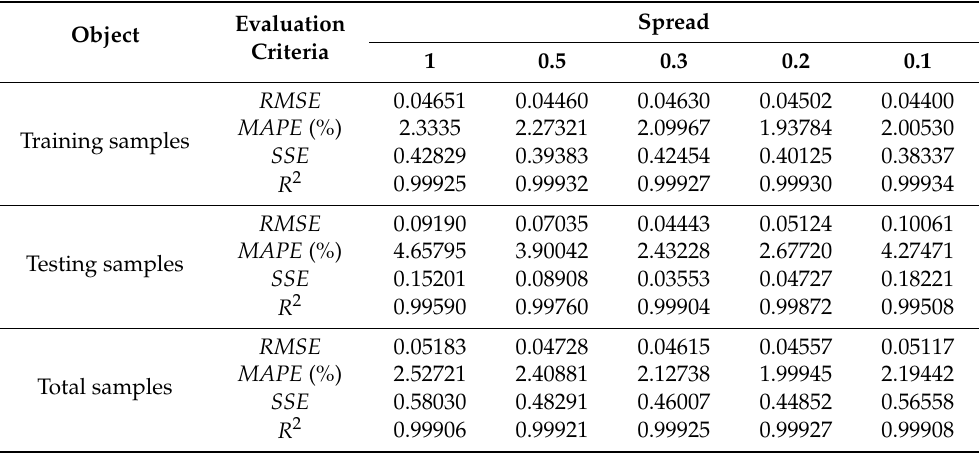
Table 3. Weight and bias coefficients of the developed RBF neural network.